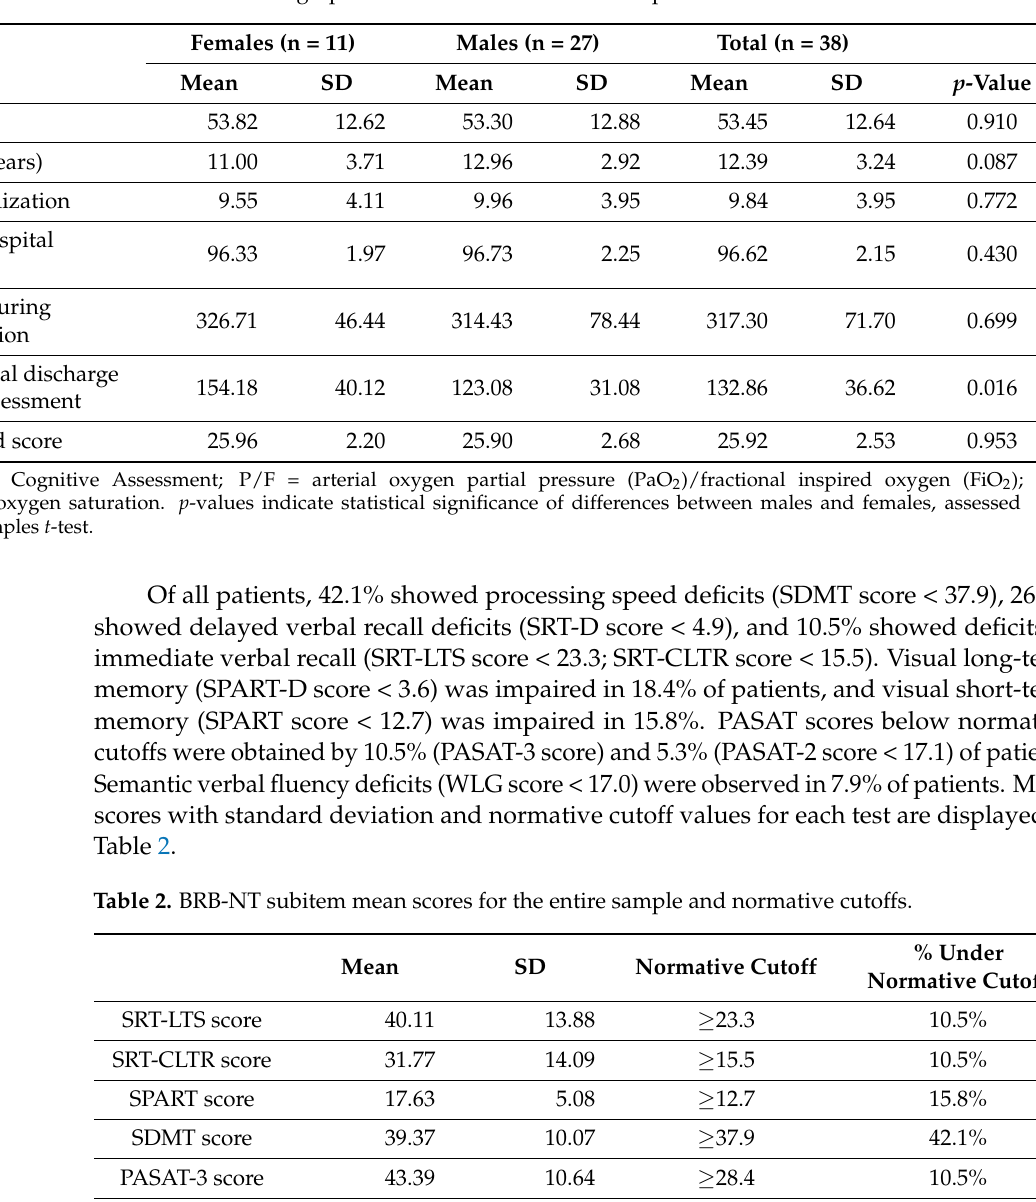
Table 1. Demographic and clinical data of our sample.